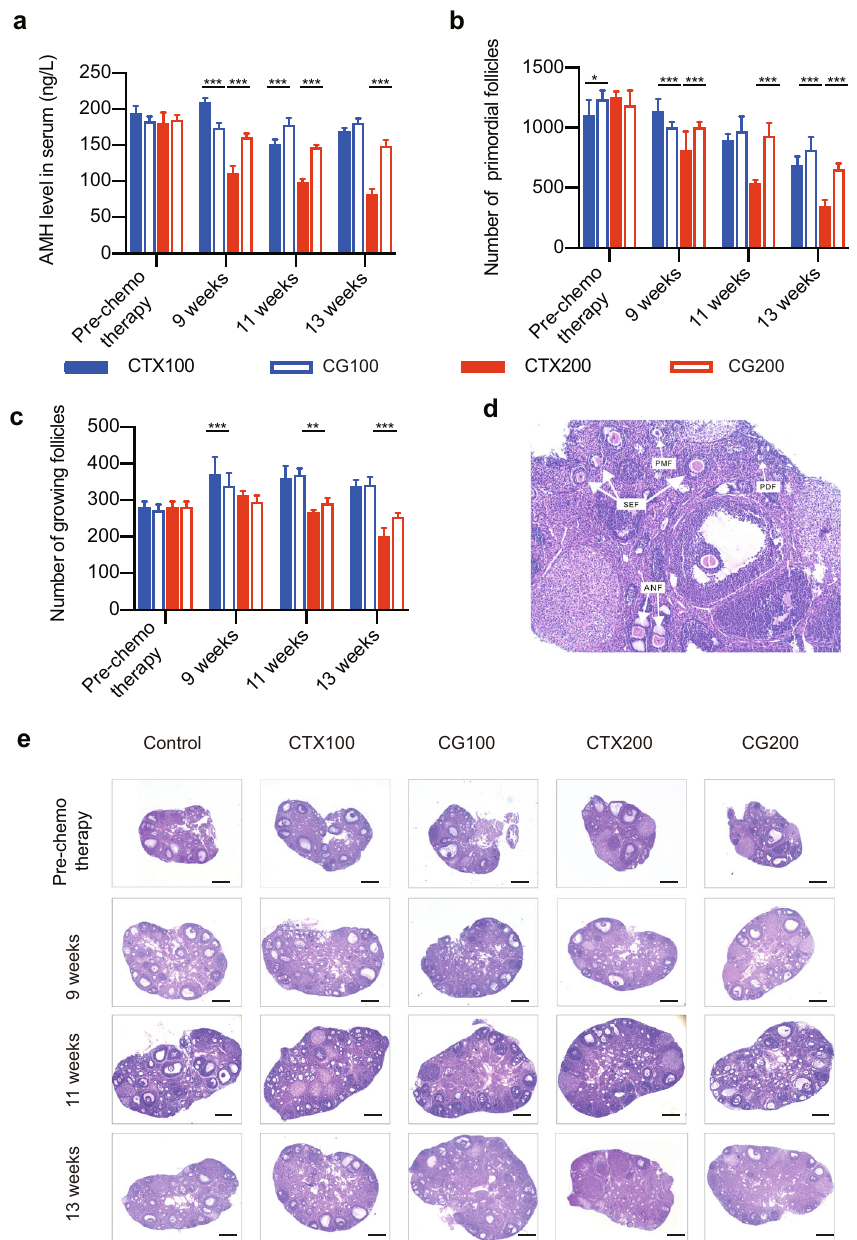
Fig. 2 Serum AMH levels and ovarian-follicle counts in tumor-bearing nude mice. a Serum AMH levels at each time point after different interventions. b Number of primordial follicles per ovary in each group. c Number of growing follicles per ovary in each group. d H&E staining of normal ovarian section. e Histologic analysis of ovaries in each group after every sacri fi ce. CTX100, 100 mg/kg CTX. CG100, 100 mg/kg CTX + Goserelin. CTX200, 200 mg/kg CTX. CG200, 200 mg/kg CTX + Goserelin. Error bars show the standard error of the mean. Two-tailed Student ’ s t test was used for statistical analysis, * P < 0.05, ** P < 0.001, and *** P < investigated by the use of TM to induce ER stress and the UPR in chaperone molecule GRP78, which is the upstream regulator of UPR sensors (Fig. 3a). Therefore, we investigated UPR activation in KGN cells. TM is an inducer of endoplasmic reticulum stress (ERS). CTX- and/or GnRHa-treated KGN cells by measuring the expression TM-induced upregulation of UPR sensors, which was reduced by of factors downstream from GRP78. Western blotting showed that GnRHa co-treatment, was suggested by western blotting for ATF4, XBP1, and CHOP were obviously upregulated in the protein expression, and con fi rmed by RT-PCR for mRNA expression presence of CTX (Fig. 5a). Meanwhile, RT-qPCR demonstrated (Fig. 5e, f). Western blotting also suggested TM-induced upregula- the signi fi cant upregulation of GRP78 , ATF4 , XBP1 , and CHOP tion of AMH protein levels in KGN cell lysates, which was mRNA expression (compared with levels in untreated control prevented by GnRHa co-treatment (Fig. 5e). Similarly, immuno- cells), suggesting that CTX-induced ER stress (Fig. 5b, c). Co- fl uorescence microscopy demonstrated high levels of colocaliza- treatment with GnRHa prevented the CTX-induced upregulation tion of AMH and GRP78 in the ER in cells treated with TM, but not of these UPR sensors, suggesting an important role for GnRHa in in cells co-treated with TM and GnRHa (Fig. 5d). blocking CTX-induced ER stress (Fig. 5a). This role was further